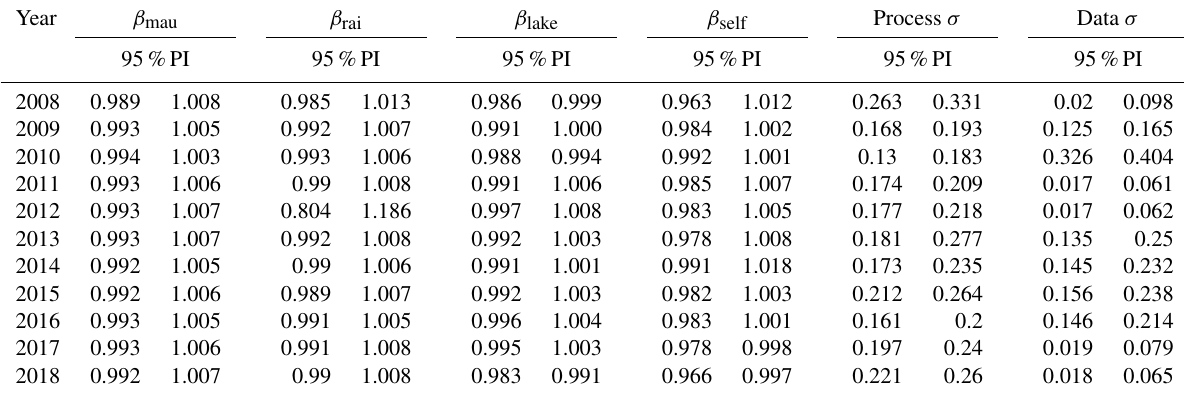
Table C1. State-space models in western Lake Erie fit coefficients predicting TP concentrations from the previous time step within the Maumee River, the Raisin River, Lake Erie, and lake locations where the current time step is informed by the same location, β mau , β rai , β lake , and β self , respectively. The 95%PI (predictive interval) for each year and coefficient was examined. The same models fit the annual process model and data model